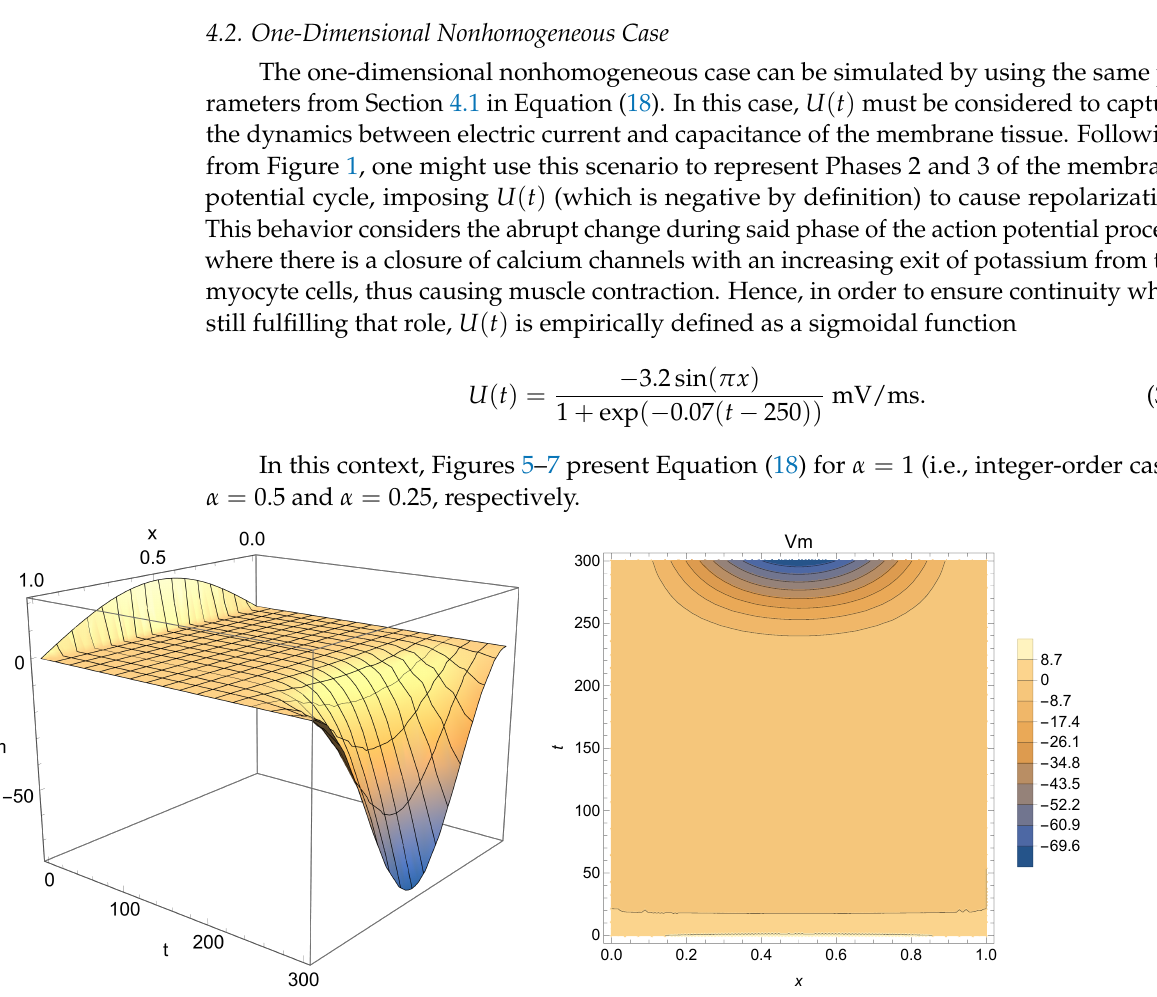
Figure 4. One-dimensional homogeneous solution describing the potential plateau after depolariza- tion: Equation (10) with α = 0.25.